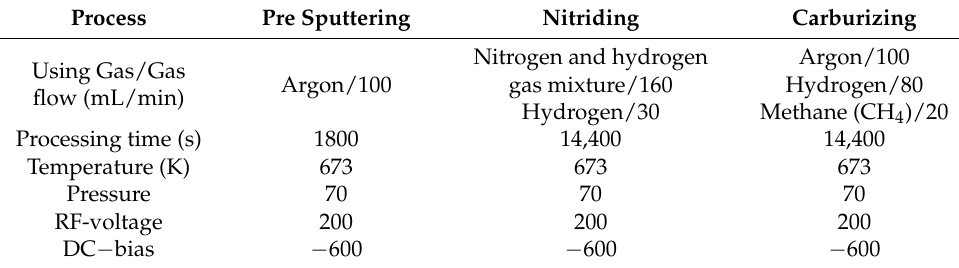
Table 1. Plasma nitriding and carburizing process conditions.